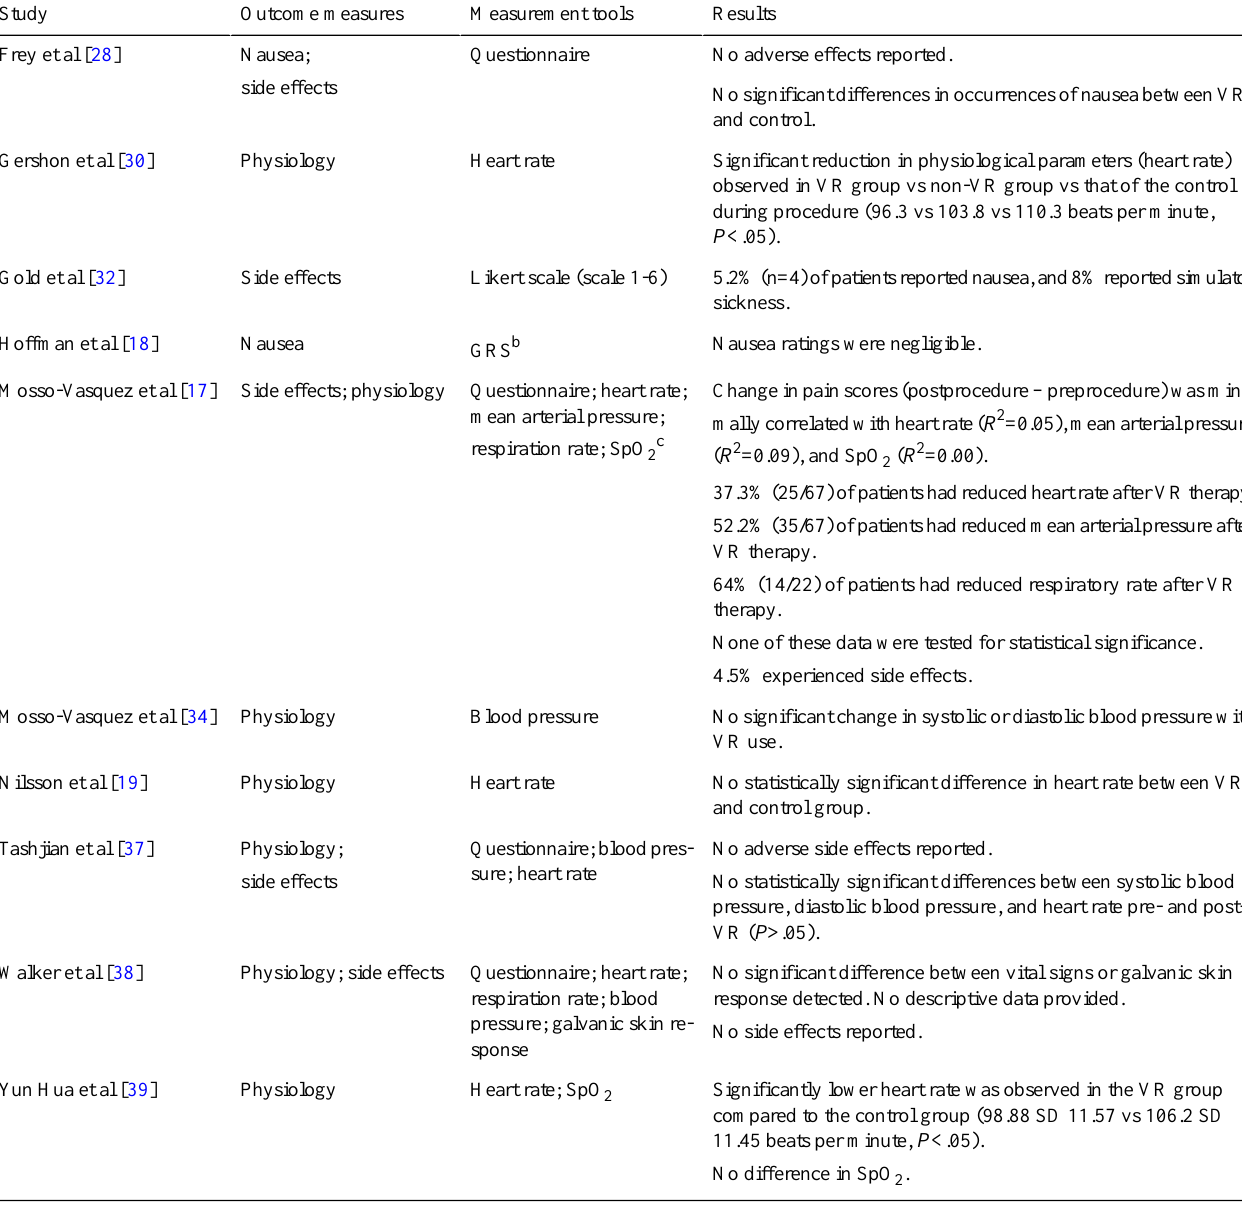
Table 4. Summary of physiological measures and side effects of studies in this review.